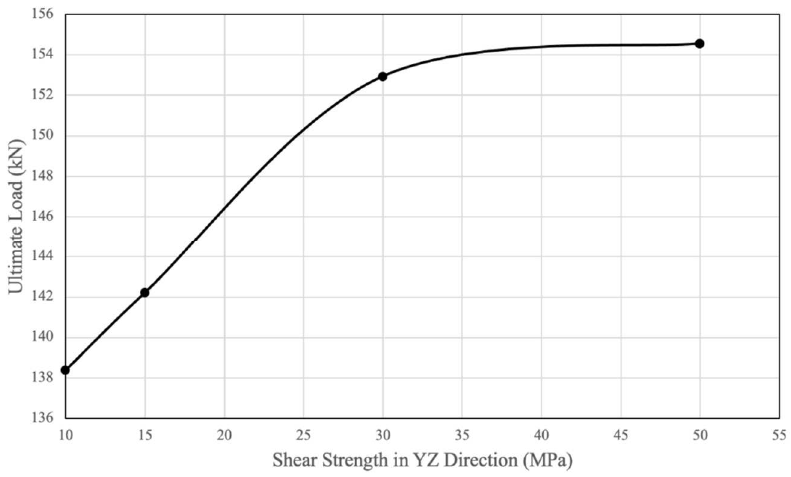
Figure 20. Impact of YZ Shear Strength on Ultimate Load.